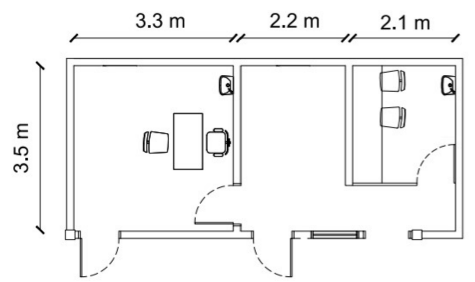
Figure 3. 2D design of the clinical care room under study located at Lauro Wanderley University